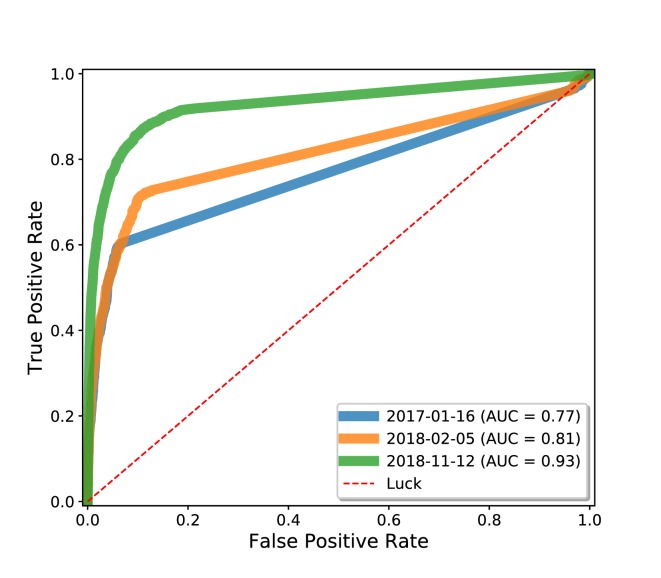
Drug repurposing using the Wikidata knowledge graph, evaluated using an external test set.The analysis in Figure 5 was based on a cross-validation of indications that were present in Wikidata. This time-resolved analysis was run using an external gold standard set of indications from Drug Central (Ursu et al., 2017).